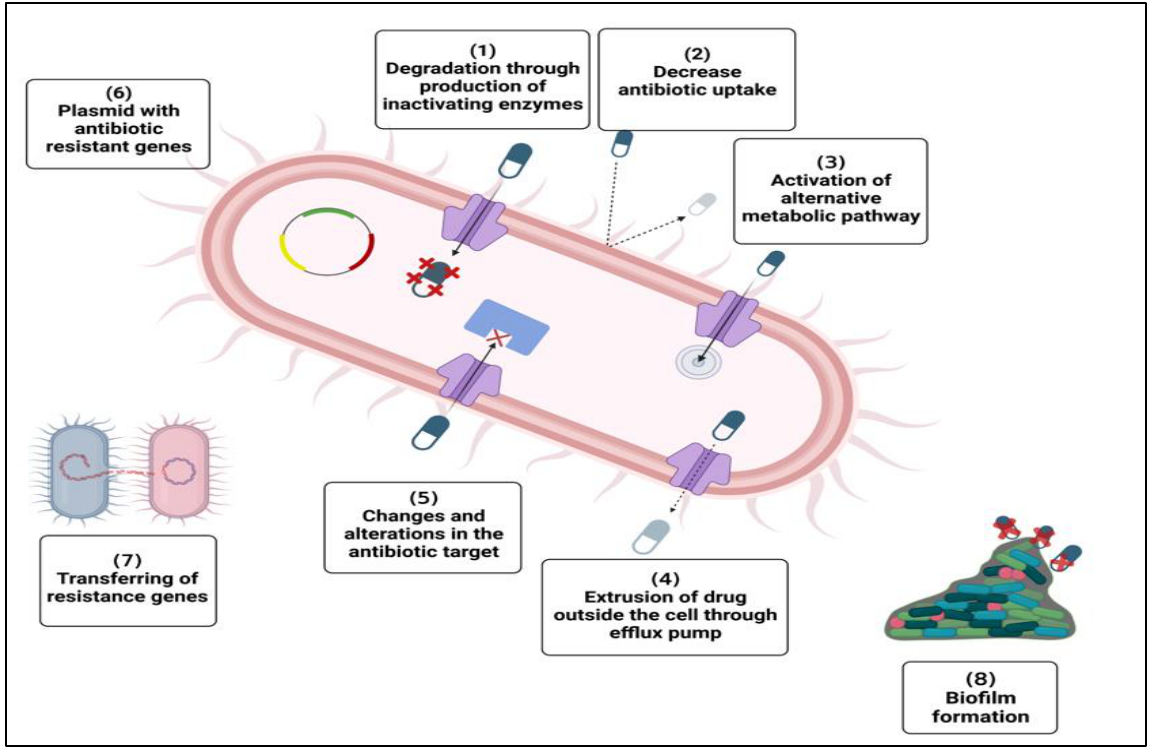
Figure 2. Mechanisms of development of antibiotic resistance. It develops through different mechanisms: (1) breakdown of drugs through production of inactivating enzyme, (2) decrease in antibiotic uptake, (3) alteration of common metabolic pathway, (4) extrusion of drug outside the cell by efflux pump, (5) change and alteration in antibiotic target, (6) presence of plasmid carrying multiple resistance genes, (7) sharing resistance gene between different bacteria, (8) formation of protective extracellular polymeric matrix.